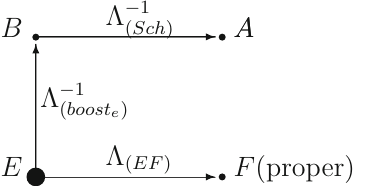
Fig. 3 A schematic representation of various pairs of the tetrad and spin connection in the e -gauge. The bold dot represents the initial tetrad (7.7) in which we “switch off” gravity